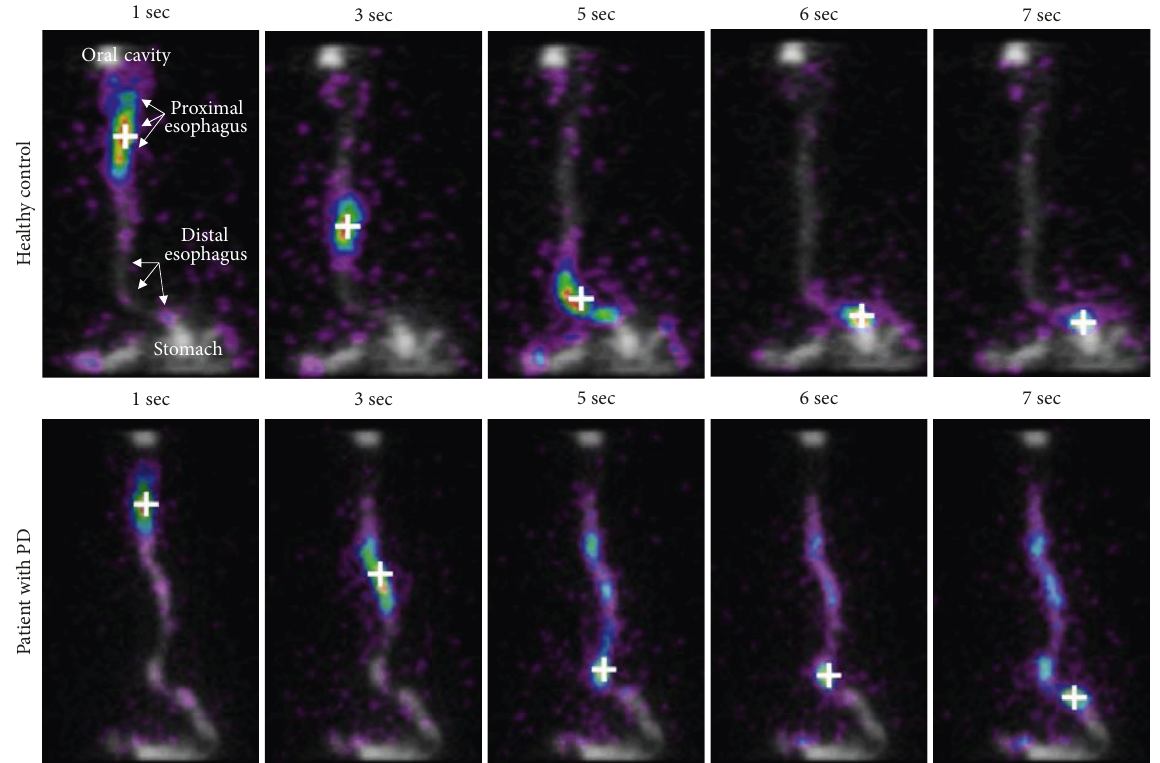
Figure 1: Serial scintigraphy images illustrating esophageal transit of a healthy control (normal transit) and a PD patient (prolonged transit). In grey is the summed activity of the whole recording, and in colors (purple to red) is shown the activity second by second. The white crosshair marks the algorithm-based estimate of the center of the